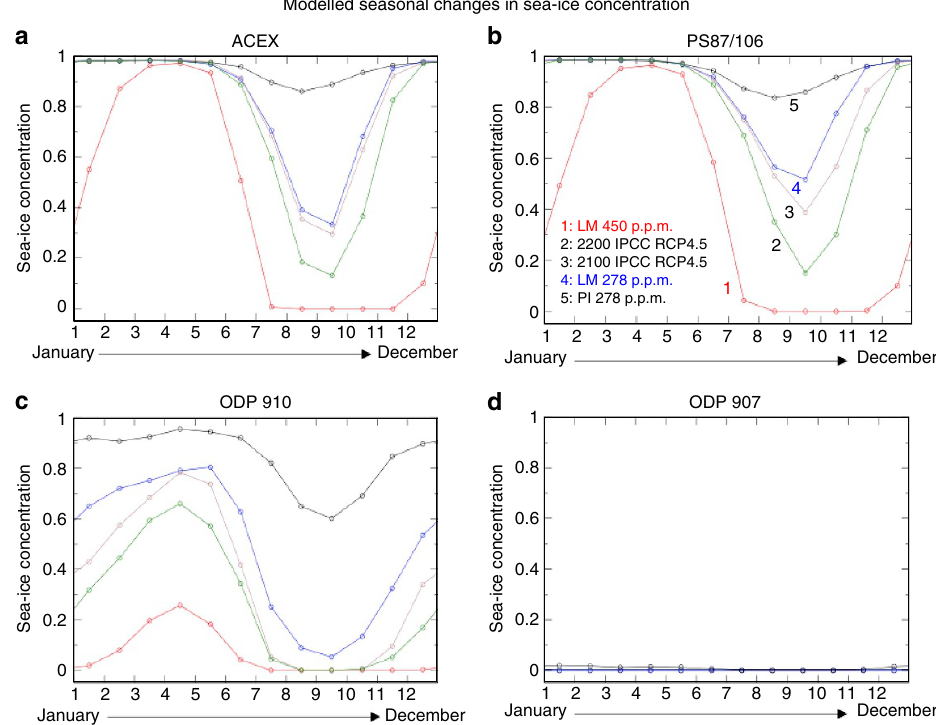
Figure 7 | Modelled monthly sea-ice concentration at the four different core locations. ( a ) ACEX Site, ( b ) Core PS87/106, ( c ) ODP Site 910 and ( d ) ODP Site 907. Climatological monthly mean sea-ice concentrations for late Miocene conditions with atmospheric CO 2 concentrations of 450p.p.m. (red curve) and 278p.p.m. (blue curve), modelled sea-ice concentration for preindustrial conditions (black curve) with an atmospheric CO 2 concentration of 278p.p.m. 32 , as well as future conditions (monthly mean 2,085–2,115, brown curve; monthly mean 2,185–2,215, green curve) following the Intergovernmental Panel on Climate Change (IPCC) medium stabilization scenario RCP4.5 (Gierz et al. 40 ) are